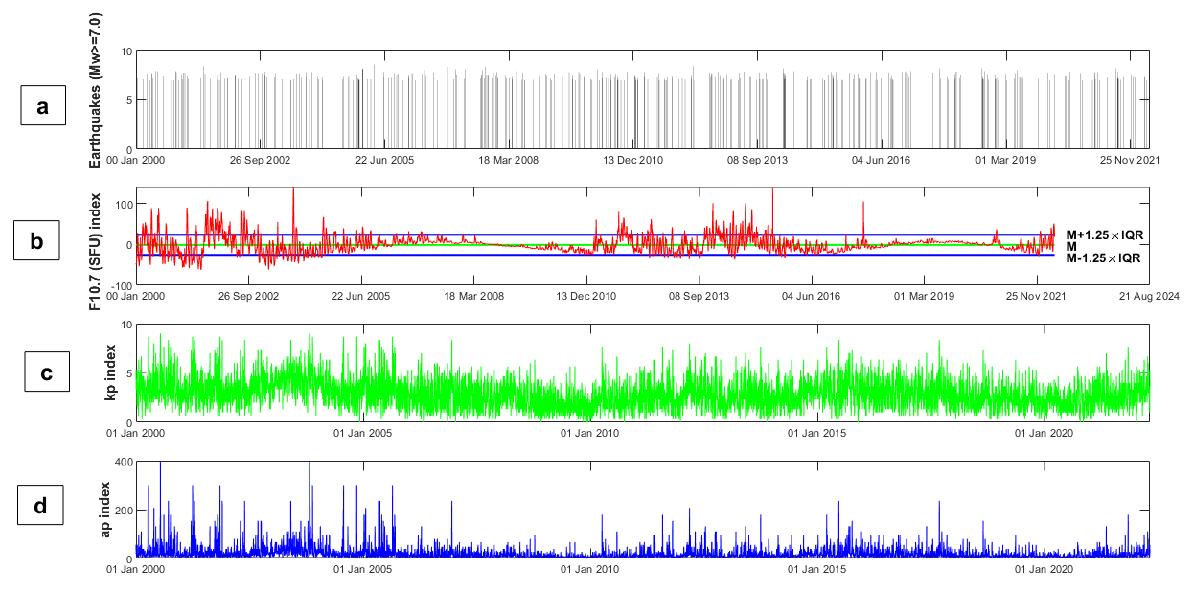
Figure 4. Time series of ( a ) global earthquake magnitudes, shown here for M ≥ 7.0 ( b ) dtrend daily average F10.7 (SFU) index, ( c ) daily average K p index, and ( d ) daily average a p index, during the periods of 1 January 2000 and 28 April 2022.